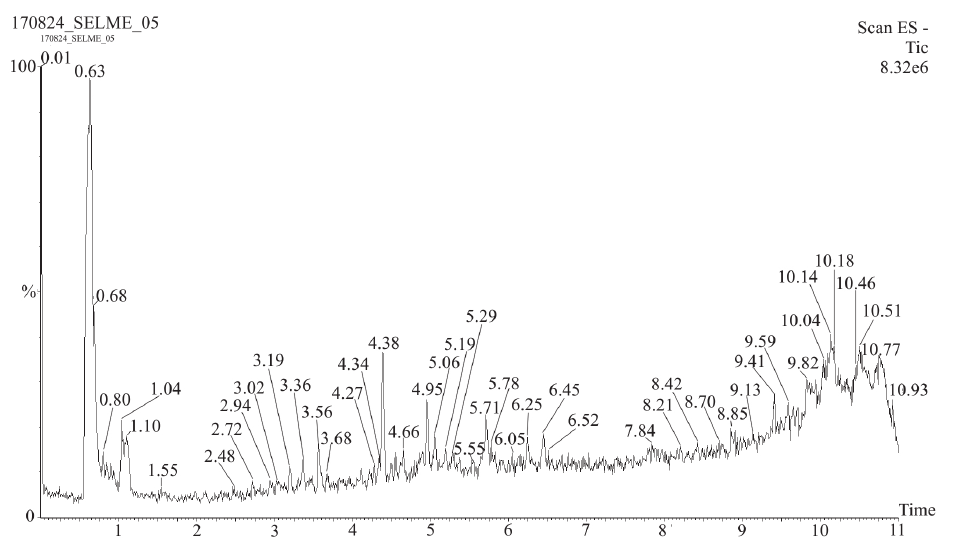
Figure 1 - UPlC-MS Chromatogram of saline extract from M. emarginata